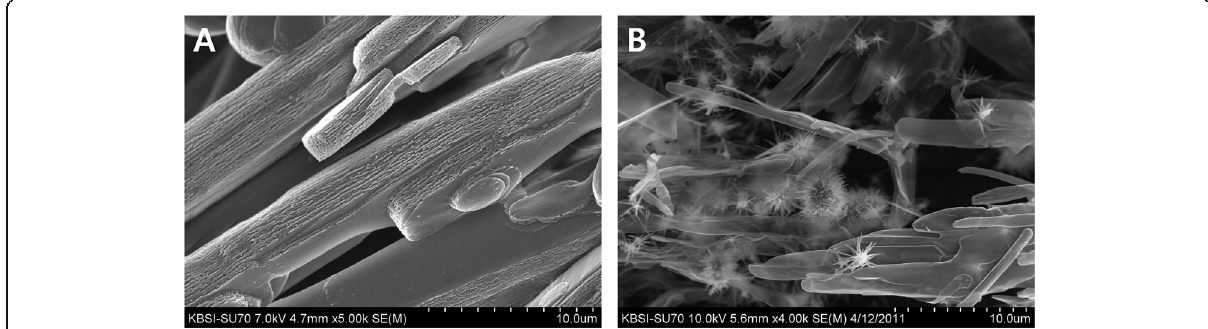
Fig. 4 Scanning microscopic image of the porcine scapula ( A ) and 4-hexylresorcinol incorporated into the scapula ( B ). 4-Hexylresorcinol- incorporated scapula shows